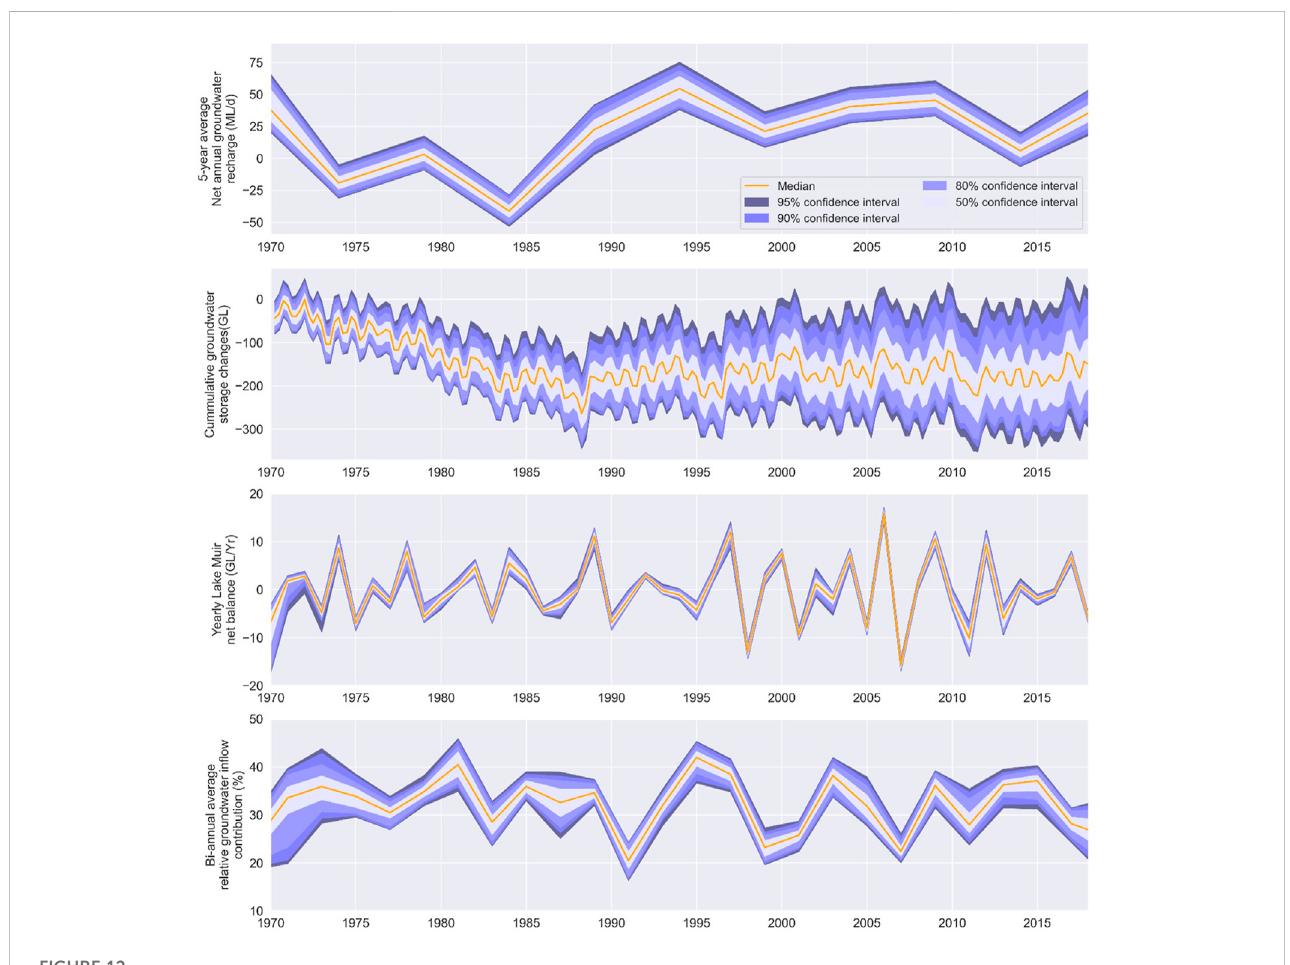
FIGURE 12 Simulated ensemble percentiles for different water balance predictive